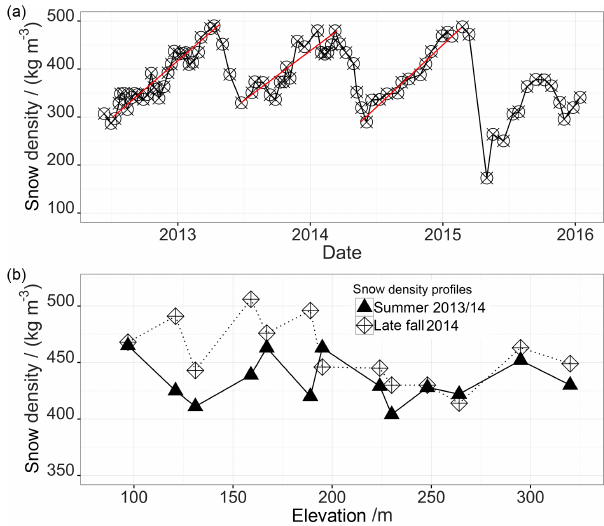
Figure 6. Displayed is the time series of snow density observations on the Fourcade Glacier, Potter Peninsula, during the time period June 2012 to February 2016 (a) . Red lines are linear regression lines from onset of winter accumulation until the end of the glaciological year. The snow density profile measurements along the mass bal- ance stake transects (see Fig. 1) on the dates 21 January 2014 (sum- mer) and 10 March 2014 (late fall) on the Fourcade Glacier, Potter Peninsula, are shown (b) . Measurements were taken at a depth of 30cm.